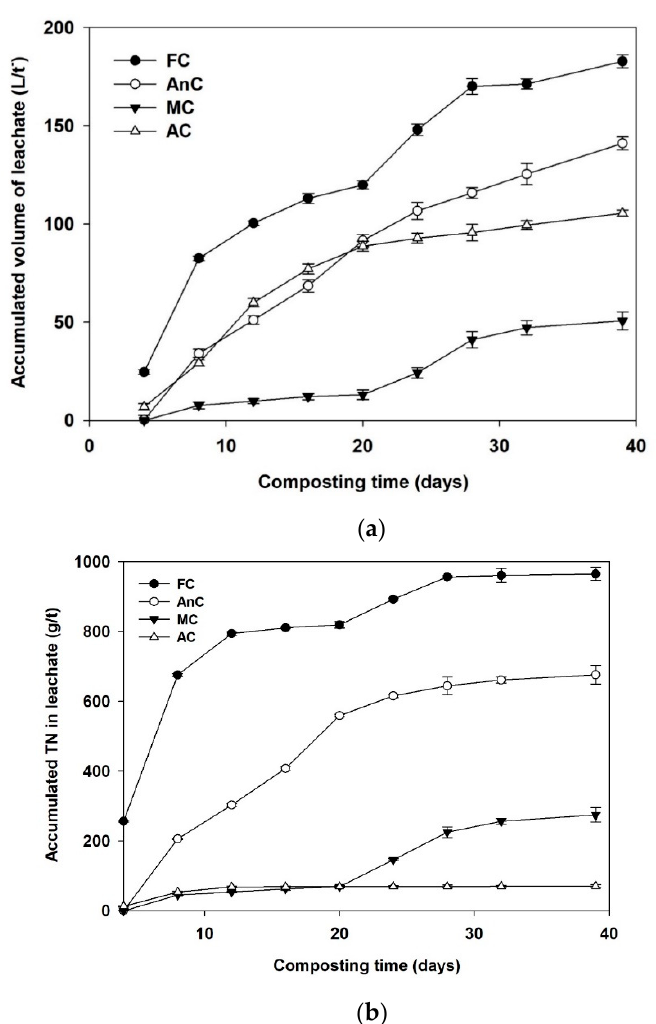
Figure 6. Accumulated volume ( a ) and total nitrogen (TN) ( b ) in the leachate during dairy manure composting. FC—farmer compost; AnC—anaerobic compost; MC—mixed compost; AC—aerobic compost.